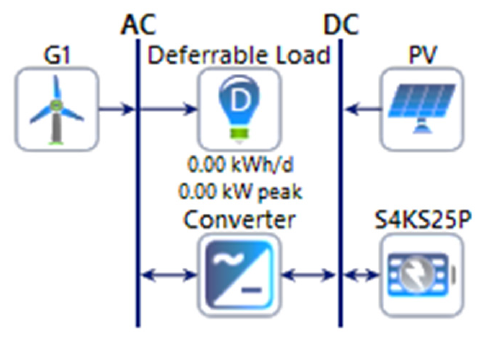
Figure 12. HOMER Pro simulation set up.